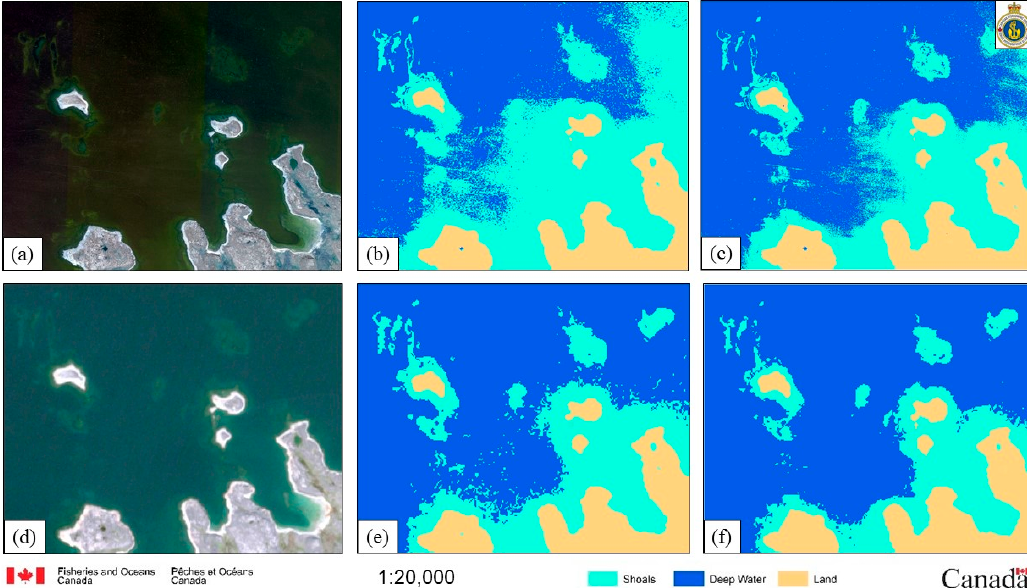
Figure 10. Automatic detection results with ( a ) a WorldView-2 image of Study Site 1, ( b ) CNN deep learning WorldView-2 results, ( c ) random forest (RF) machine learning WorldView-2 results, ( d ) a Sentinel-2 image of Study Site 1, ( e ) CNN deep learning Sentinel results, and ( f ) RF machine learning Sentinel results. © 2017, DigitalGlobe and 2019, Copernicus.